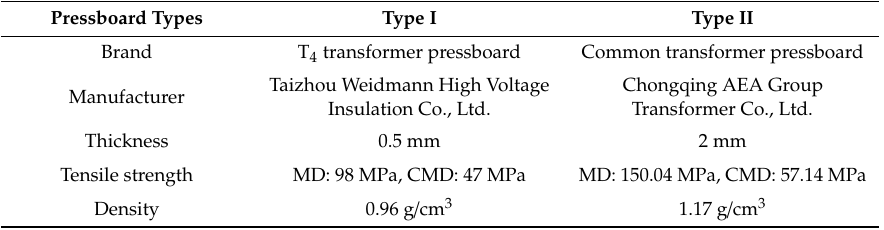
Table 1. The comparison of the parameters of two